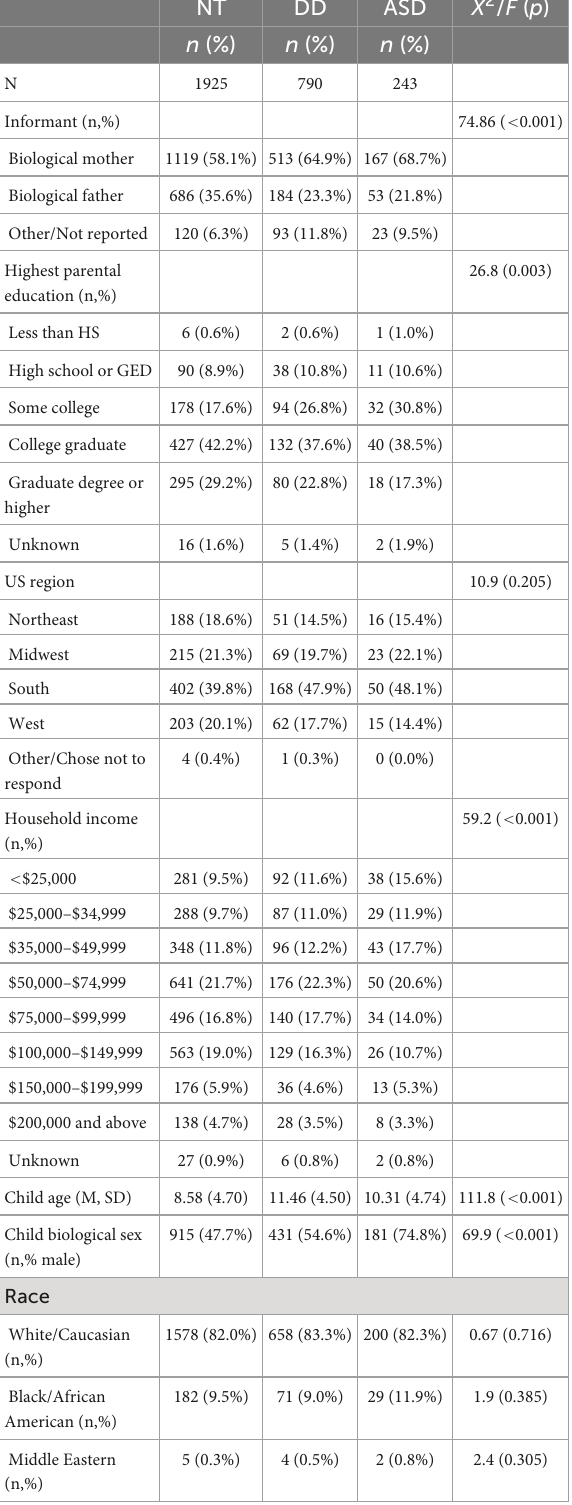
TABLE 1 Demographic and clinical characteristics across autism spectrum disorder (ASD), developmental disability (DD), and neurotypical (NT) controls across exploratory and confirmatory